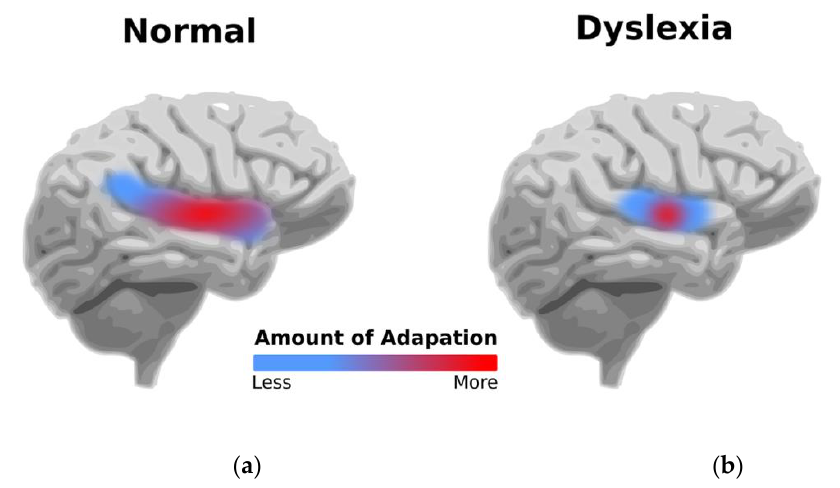
Figure 2. ( a ) Large neural adaptation in normal brain and ( b ) reduced neural adaptation in dyslexic brain.